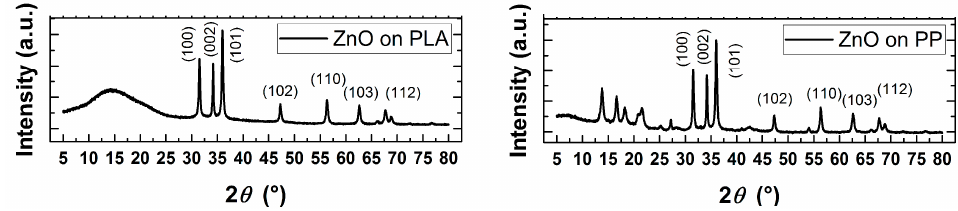
Figure 4. X-ray diffraction (XRD) pattern of sample ZnO@PLA and ZnO@PP.